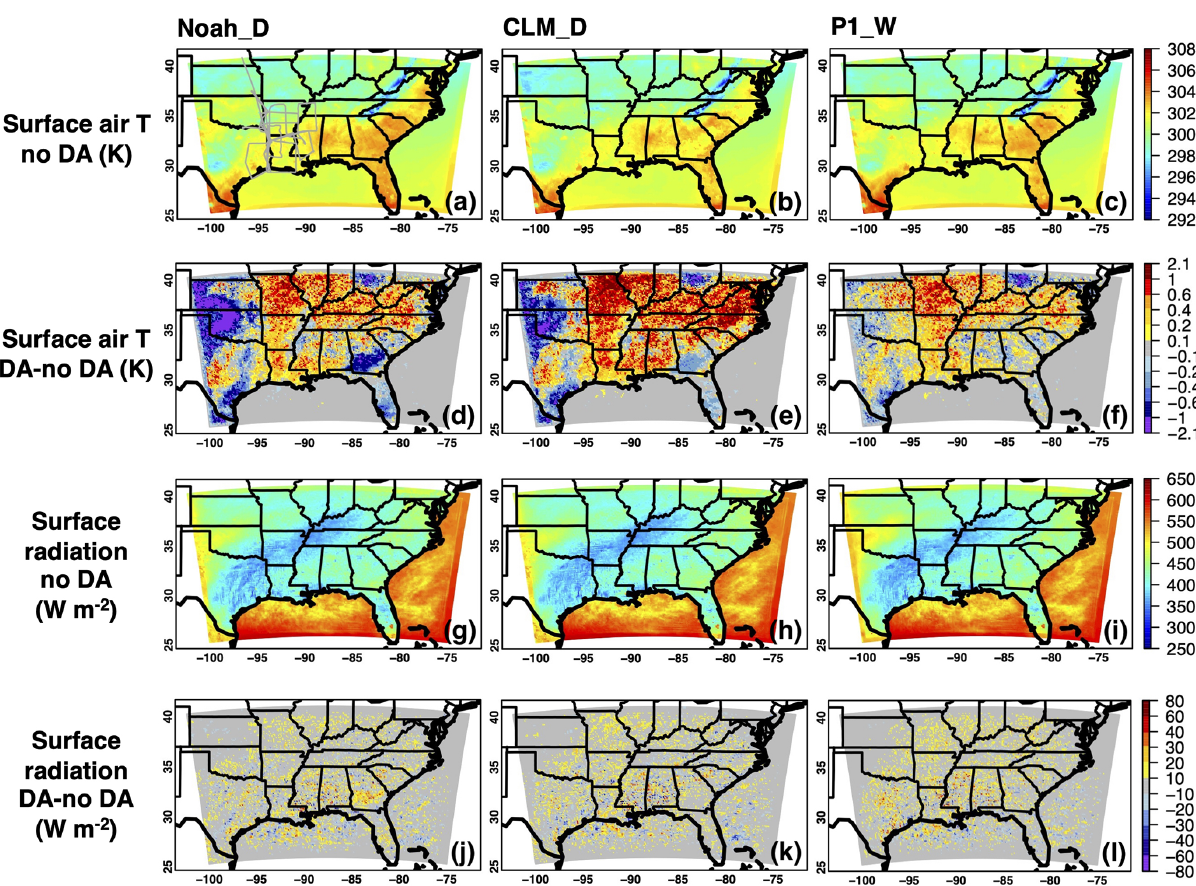
Figure 5. Period-mean (16–28 August 2016) WRF-Chem calculated daytime (a–c) surface air temperature and (g–i) surface radiation as well as (d–f, j–l) their responses to the SMAP DA. Results based on the Noah_D, CLM_D, and P1_W cases are shown in (a) , (d) , (g) , and (j) , (b) , (e) , (h) , and (k) , and (c) , (f) , (i) , and (l) , respectively. Overall, the weather fields from Noah_D and Noah_W (not shown in figures) cases are nearly the same. Grey lines in (a) indicate the B-200 flight paths over the southeastern US during the 2016 ACT-America